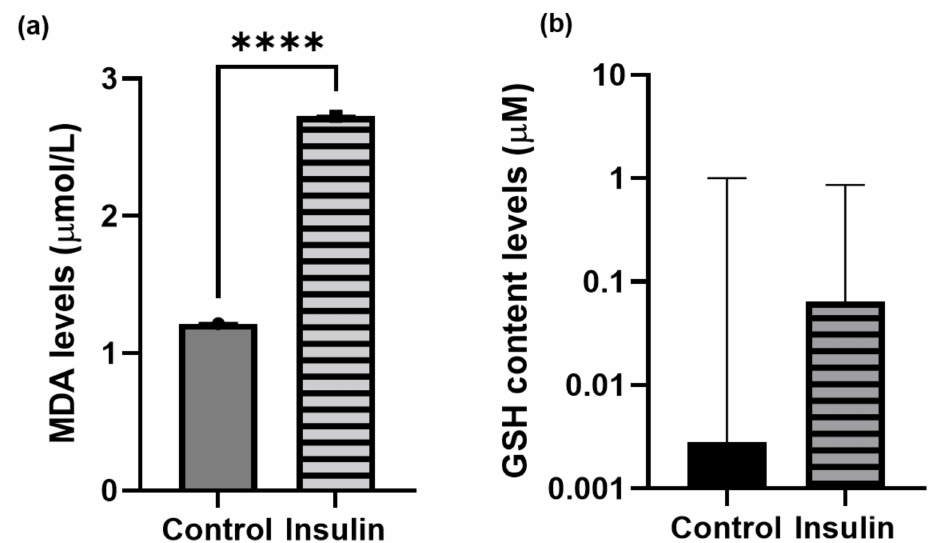
Figure 4. Unpaired t -test analysis. Data of ( a ) MDA and ( b ) GSH levels are expressed in mean ± SEM with three independent replications for each group pooled with 20 larvae. Statistical analyses are expressed as p < 0.001 (****).